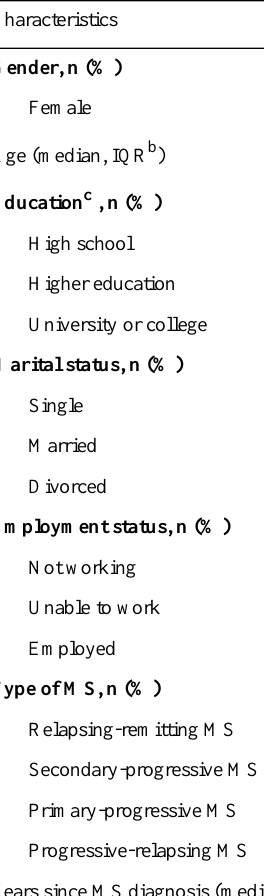
Table 1. Participant characteristics: persons with multiple